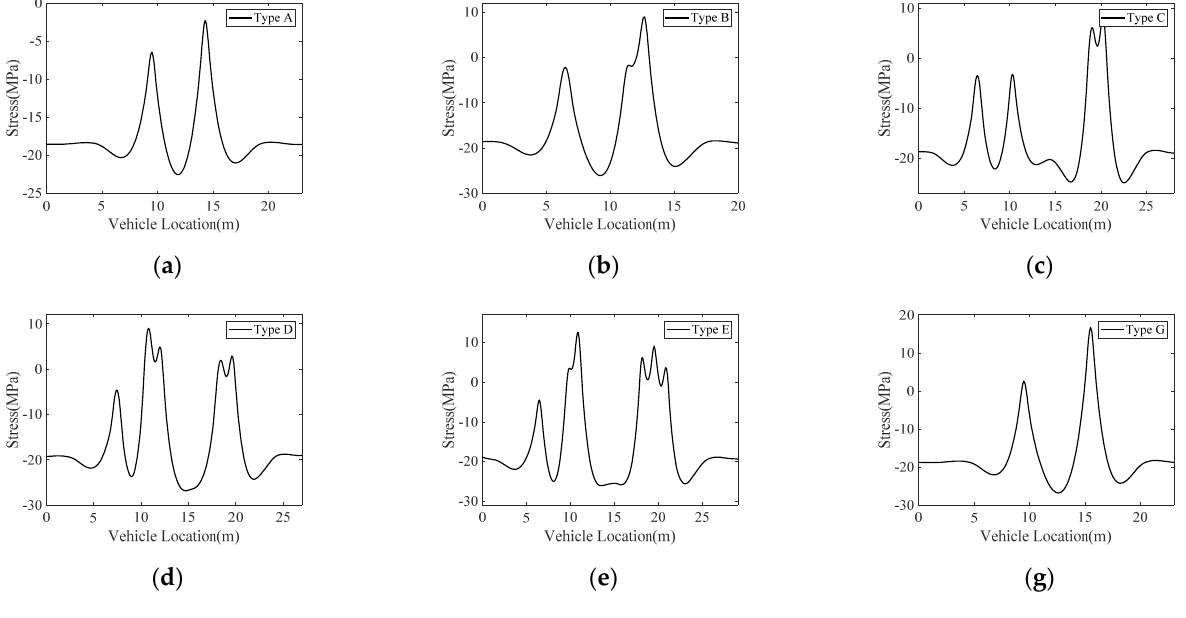
Figure 8. Time histories of vehicle-induced nominal stress at the critical location for different vehicle types. ( a ) Type A. ( b ) Type B. ( c ) Type C. ( d ) Type D. ( e ) Type E. ( g ) Type